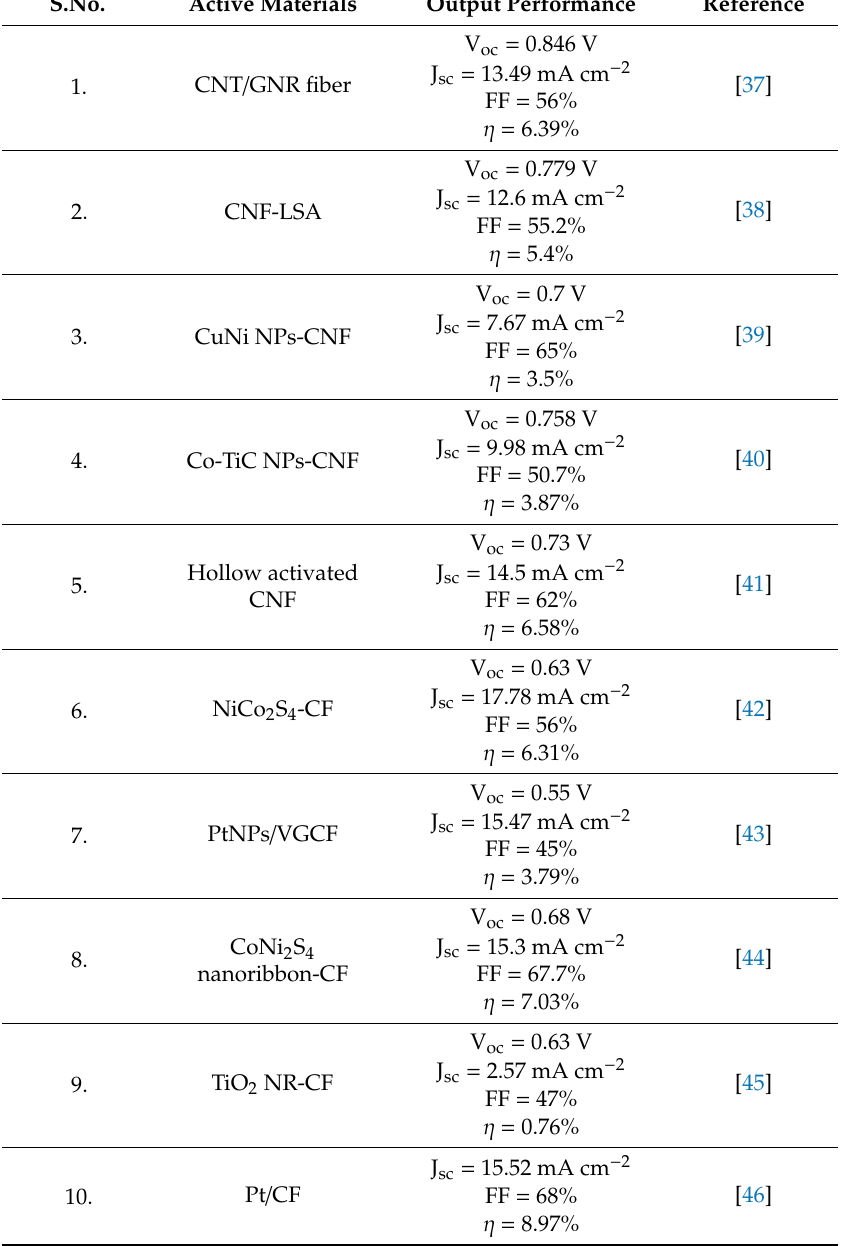
Table 1. Summary of output characteristics of CF-based